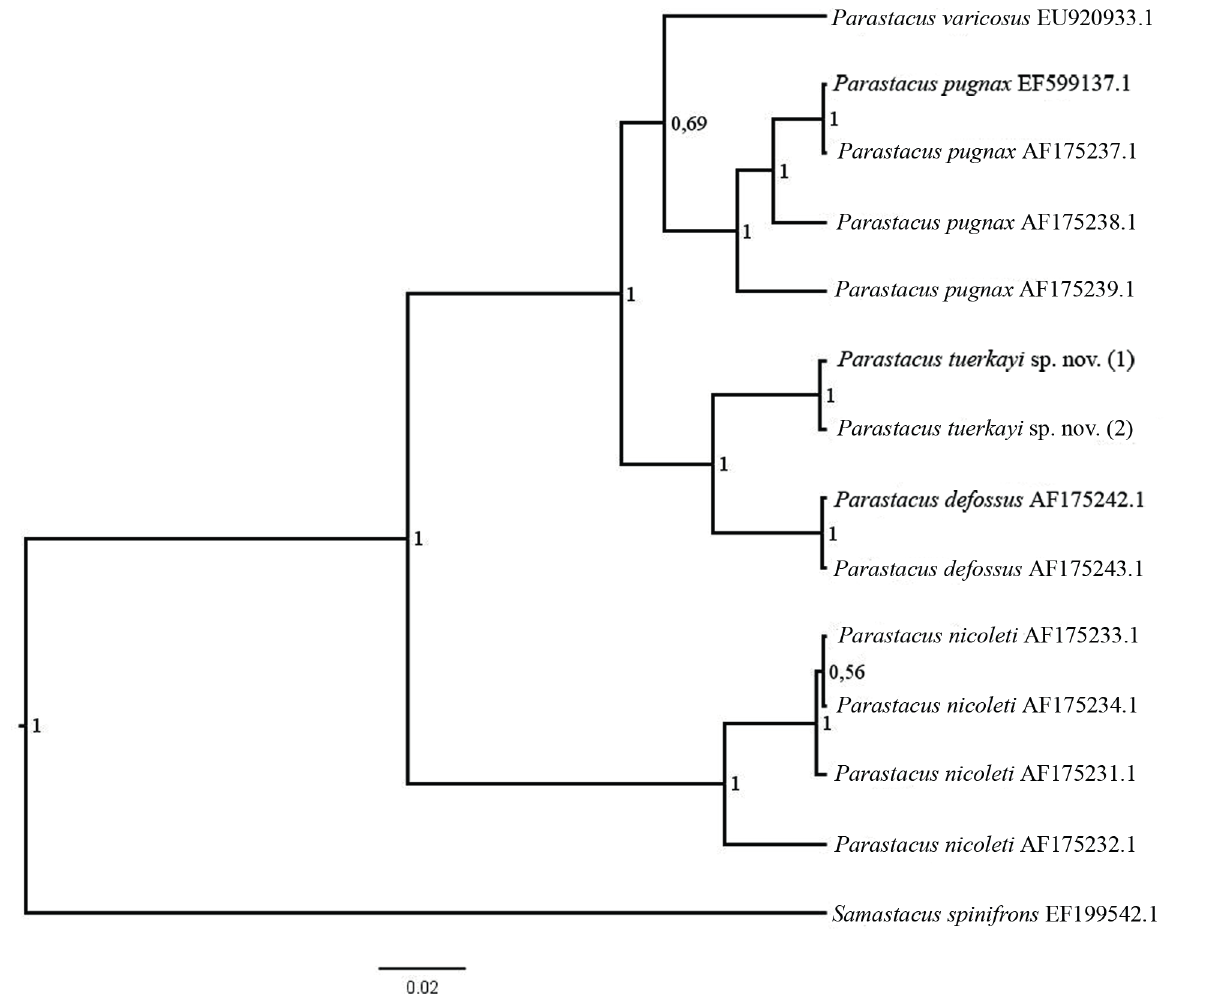
Figure 6. Bayesian inference estimate of phylogenetic relationships among selected species of South American freshwater crayfish based on 16S rRNA gene data from the mitochondrial genome. Parastacus tuerkayi sp. nov. (1) and (2) are respectively paratype (UFRGS 6438) and holotype.